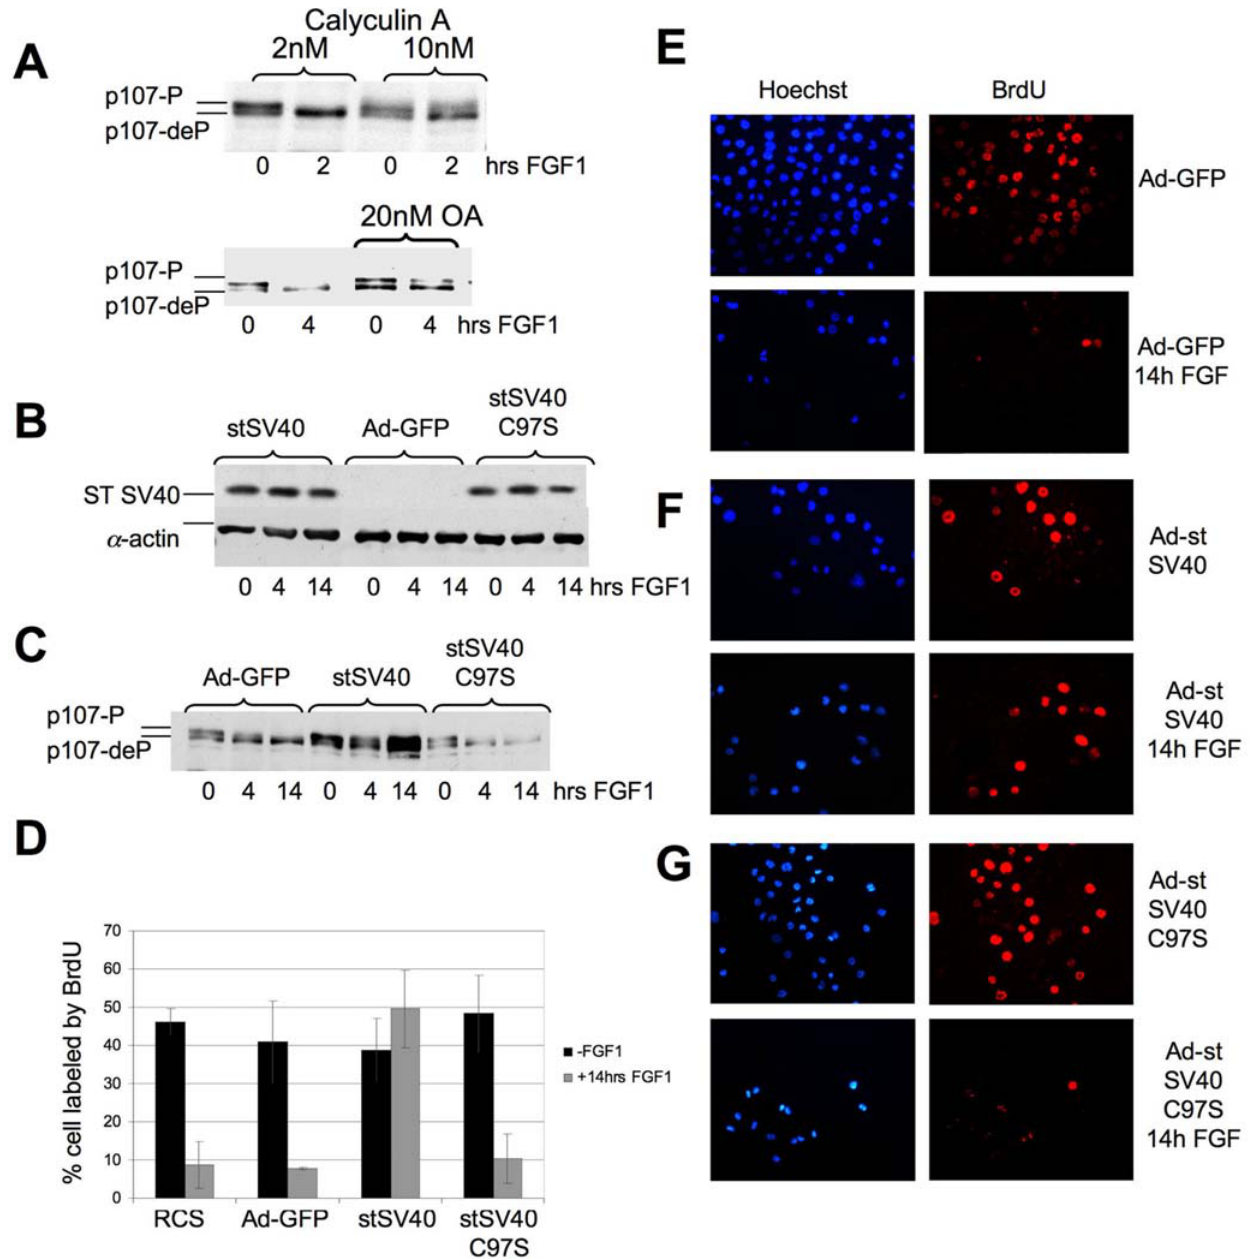
Figure 3. FGF-induced dephosphorylation of p107 is prevented by protein phosphatase inhibitors and by SV40 small t-antigen (st SV40). (A) RCS cells were pretreated with either okadaic acid (OA) or Calyculin A 2 hours before FGF treatment. 20 m g of total protein were subjected to SDS-PAGE following inmmunodetection of p107. (B–G) RCS cells were infected with adenoviruses expressing GFP, st SV40 or st SV40 mutant C97S following FGF1 treatment as indicated. (B,C) 20 m g of total protein were used for immmunodetection of (B) st SV40 and (C) p107. Equal amount of protein loading was confirmed by a -actin immunodetection. (D–G) BrdU incorporation assay of FGF treated or untreated RCS cells expressing either GFP, st SV40, or st SV40 C97S mutant. BrdU was detected by using BrdU antibodies (red). Nuclei were stained with DAPI (blue). (D) Summary of results in panels E–G. doi:10.1371/journal.pone.0003447.g003 lethality of PP2A knockdown precluded the isolation of pure FGF induces an association of PP2A with p107 in RCS population of cells with substantially reduced levels of PP2A, the chondrocytes prevention of the FGF-induced p107 dephosphorylation and To gain additional evidence for the hypothesis that FGF targets growth arrest we observed was significant and reproducible in PP2A to p107 and causes p107 dephosphorylation, we immuno- independent experiments. We therefore conclude that PP2A precipitated either p107 or the PP2A-C subunit from FGF-treated function is required for the dephosphorylation of p107 and RCS cells and determined whether an association between endogenous p107 and PP2A was induced by FGF treatment. consequent growth arrest induced by FGF in RCS chondrocytes.